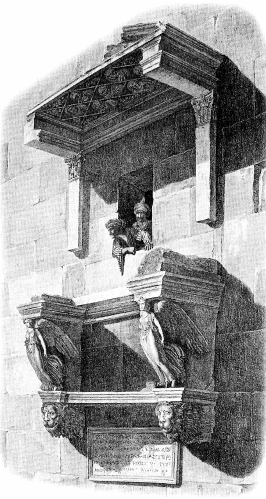
Figure 2. A 18 th century drawing of a window balcony with architectural decorations in the Tomb of Jamblique in Palmyra by F. Cassas.